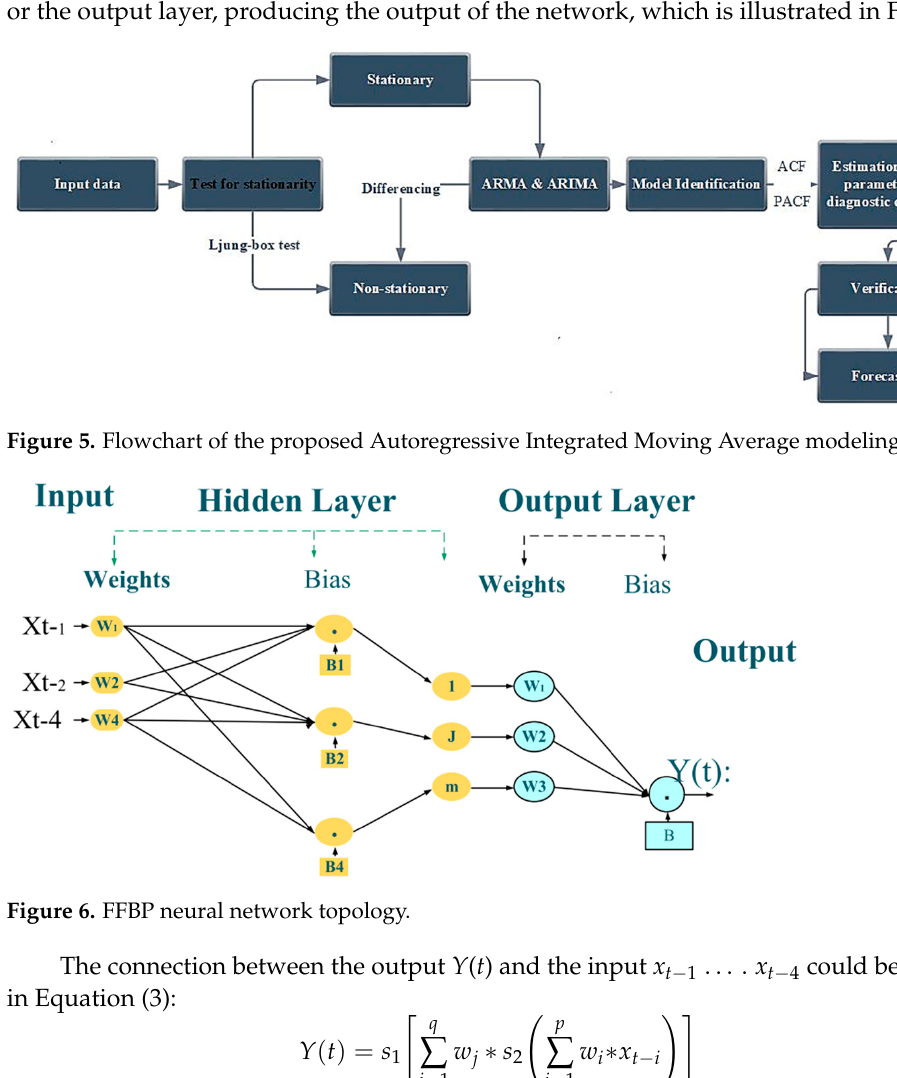
Figure 5. Flowchart of the proposed Autoregressive Integrated Moving Average modeling of daily.